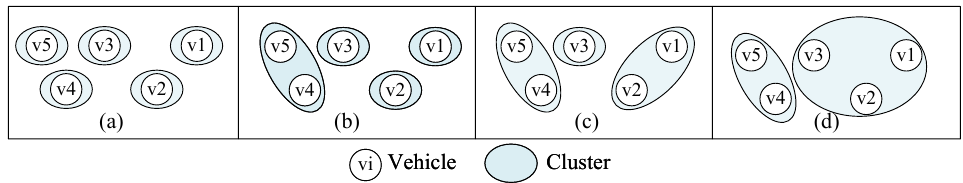
Figure 3. Schematic diagram of the cluster process. ( a ) The initialization before starting the cluster, ( b – d ) the process of the